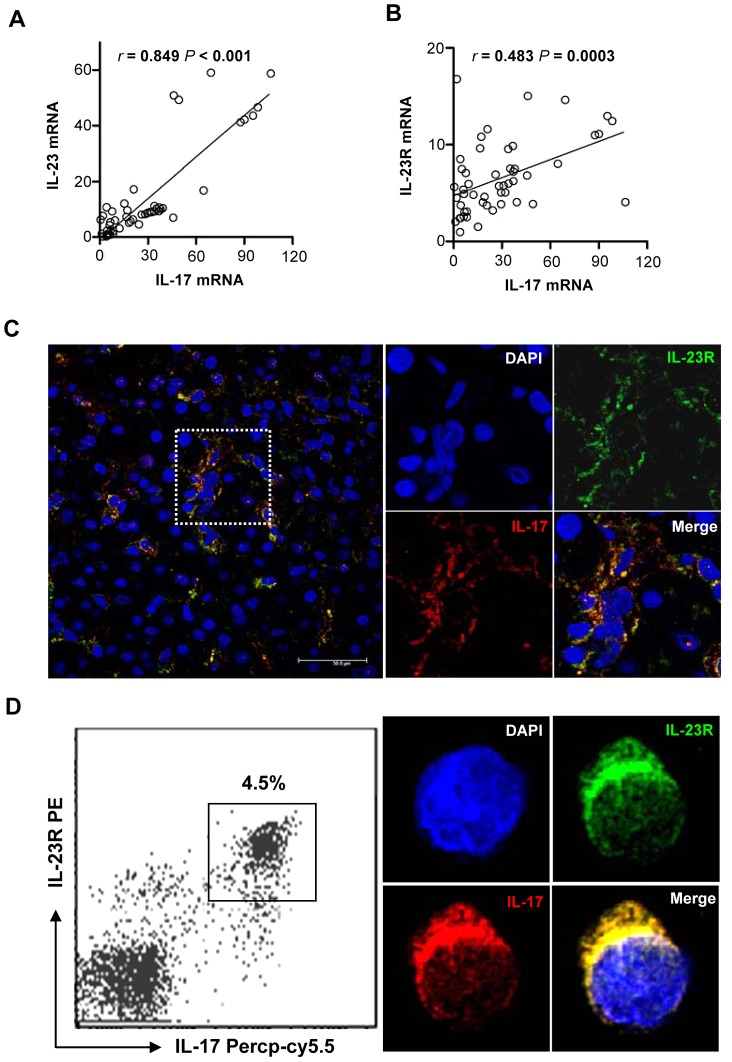
Hepatic IL-23/IL-23R is closely correlated with elevated IL-17, and IL-23R+ T cells are the main source of IL-17 in liver of CHB and ACLF patients.Relative mRNA expressions of IL-23, IL-23R and IL-17 in liver tissues infected by HBV were assayed by qPCR, and then Spearman's rank correlation was used to determine the correlation between relative mRNA expression of (A) IL-23 or (B) IL-23R and IL-17 in 51 CHB patients. Co-localization of IL-17 (red) with IL-23R (green) (C) in CHB patients' liver tissues was examined by fluorescence microscope. The right panels are enlarged images of the area in the left panel demarcated with the white dashed-line box. (D) Co-localization of IL-17 and IL-23R in PBMCs from hepatitis B patients is shown. PBMCs from patients with CHB were stimulated by PMA and ionomycin for 4 h in the presence of GolgiStop. A moiety of the stimulated PBMCs was measured by FCM to determine the frequency of IL-17+23R+ T cells in the total CD4+ T cells, with gating on CD3+CD8− T cells. Co-localization of IL-17 (red) and IL-23R (green) in the smear of stimulated PBMCs was examined by confocal microscopy. The data shown are representative from one of the five CHB patients.